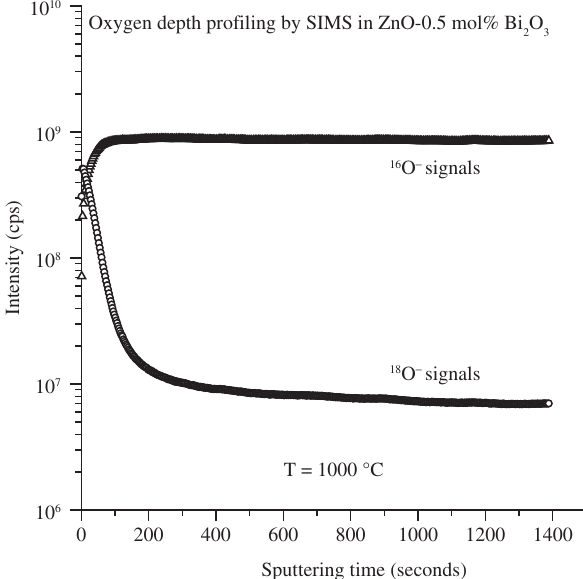
Figure 1. SIMS analysis showing the 16 O – and 18 O – signals after oxygen dif- fusion in ZnO-0.5 mol % Bi